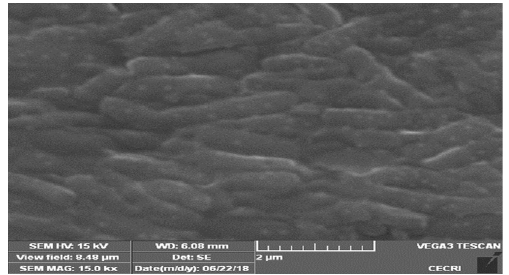
Fig. 2. SEM image of Acintobacter junii